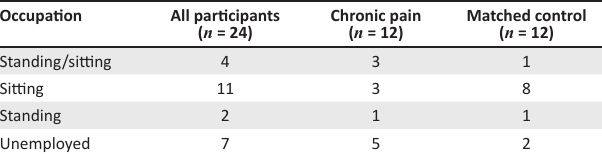
TABLE 2: Occupational characteristics of all participants ( N = 24).